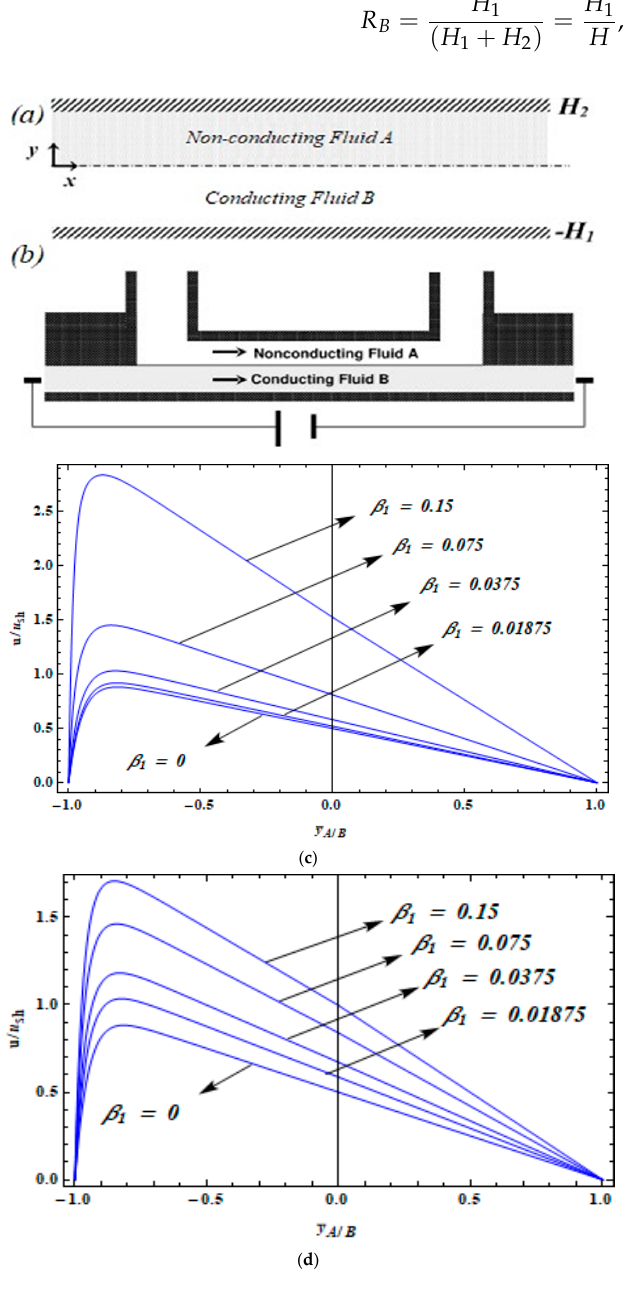
Figure 1. ( a ) Schematic diagram of flow geometry in a channel. ( b ) The diagram of EOF pump. ( c ) 𝛽 = 1;𝛤 = 0;𝑅 = 20;𝑅 (cid:3085) = 0;𝑅 (cid:3002) = (cid:2869) ; ( d ) 𝛽 = 1;𝛤 = 0;𝑅 = 20;𝑅 (cid:3085) = 0;𝑅 (cid:3002) = (cid:2869) (cid:2870)